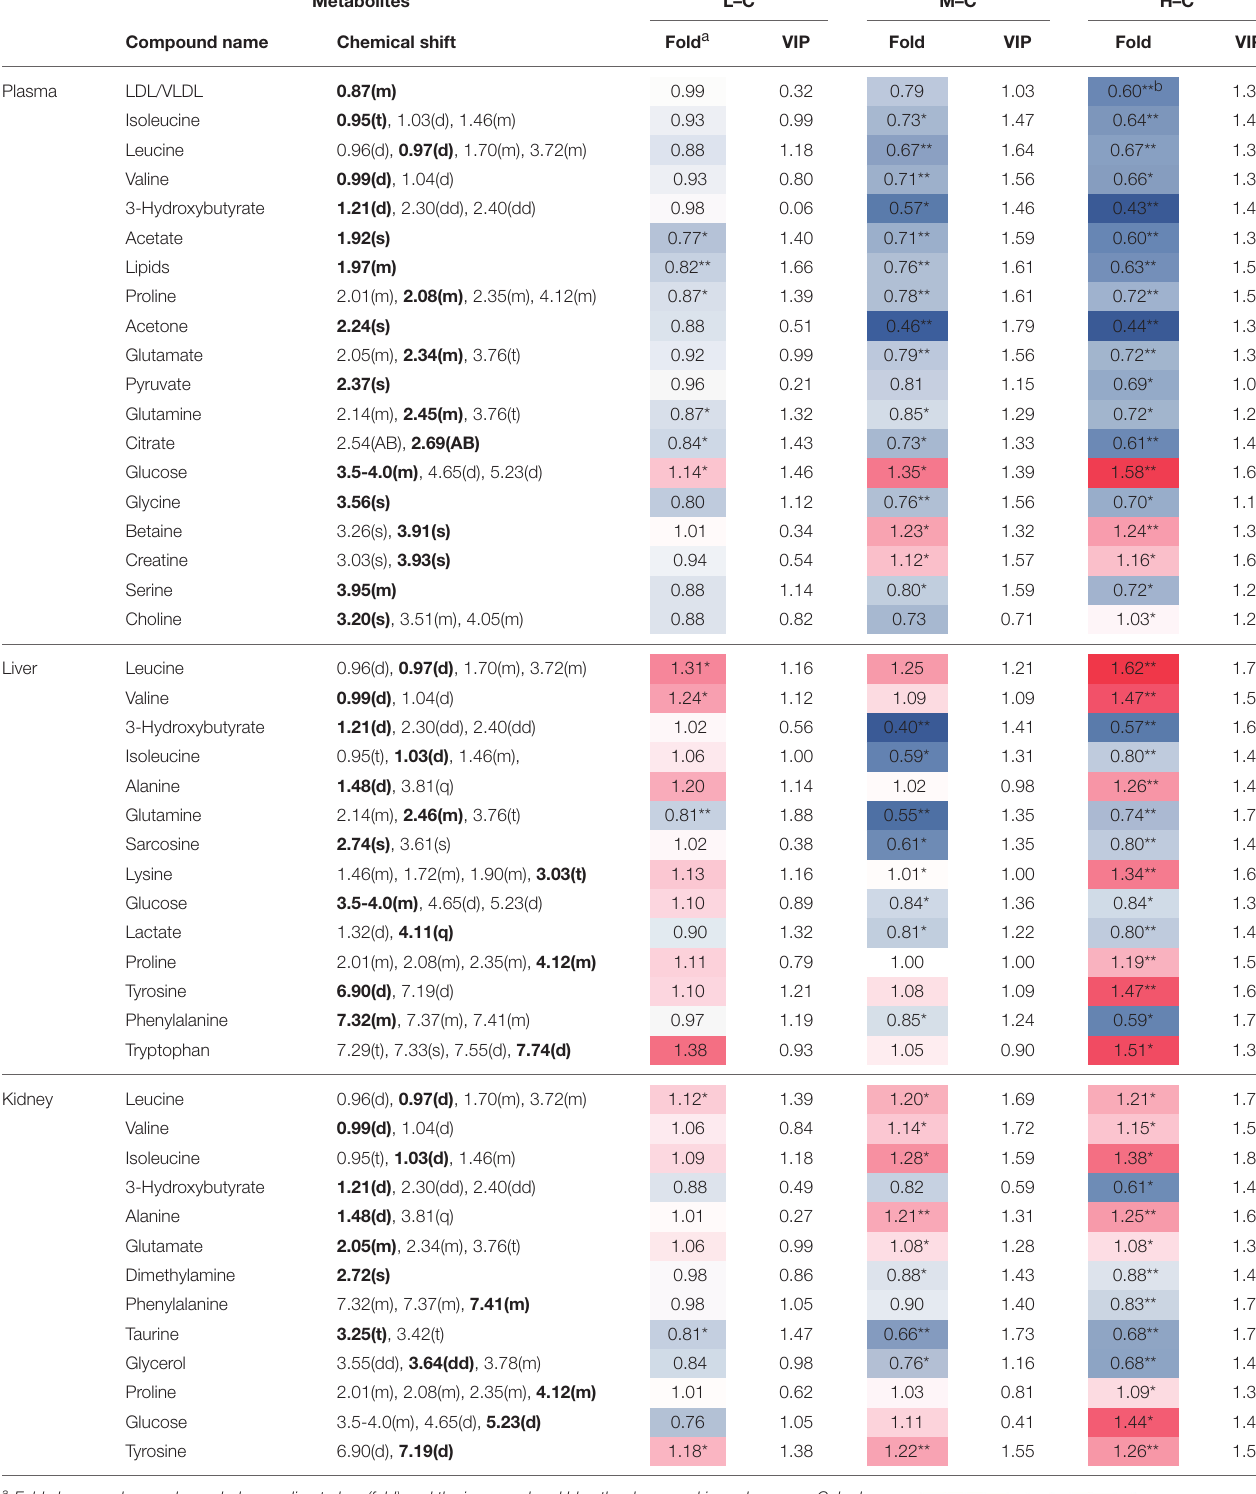
TABLE 1 | Significant change of the metabolites derived from the NMR data from different group at day